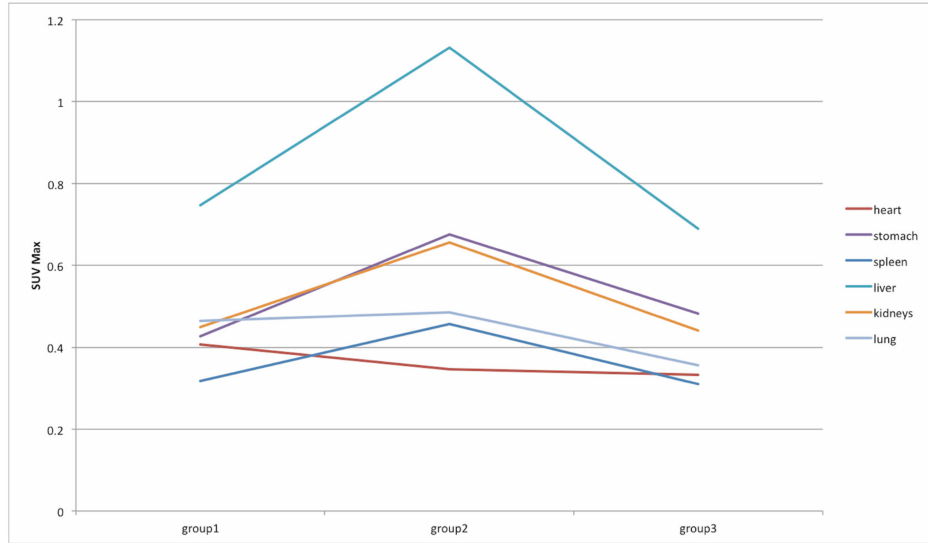
Figure 10. SUV max variations among groups in heart, stomach, spleen, liver, kidneys, and lung